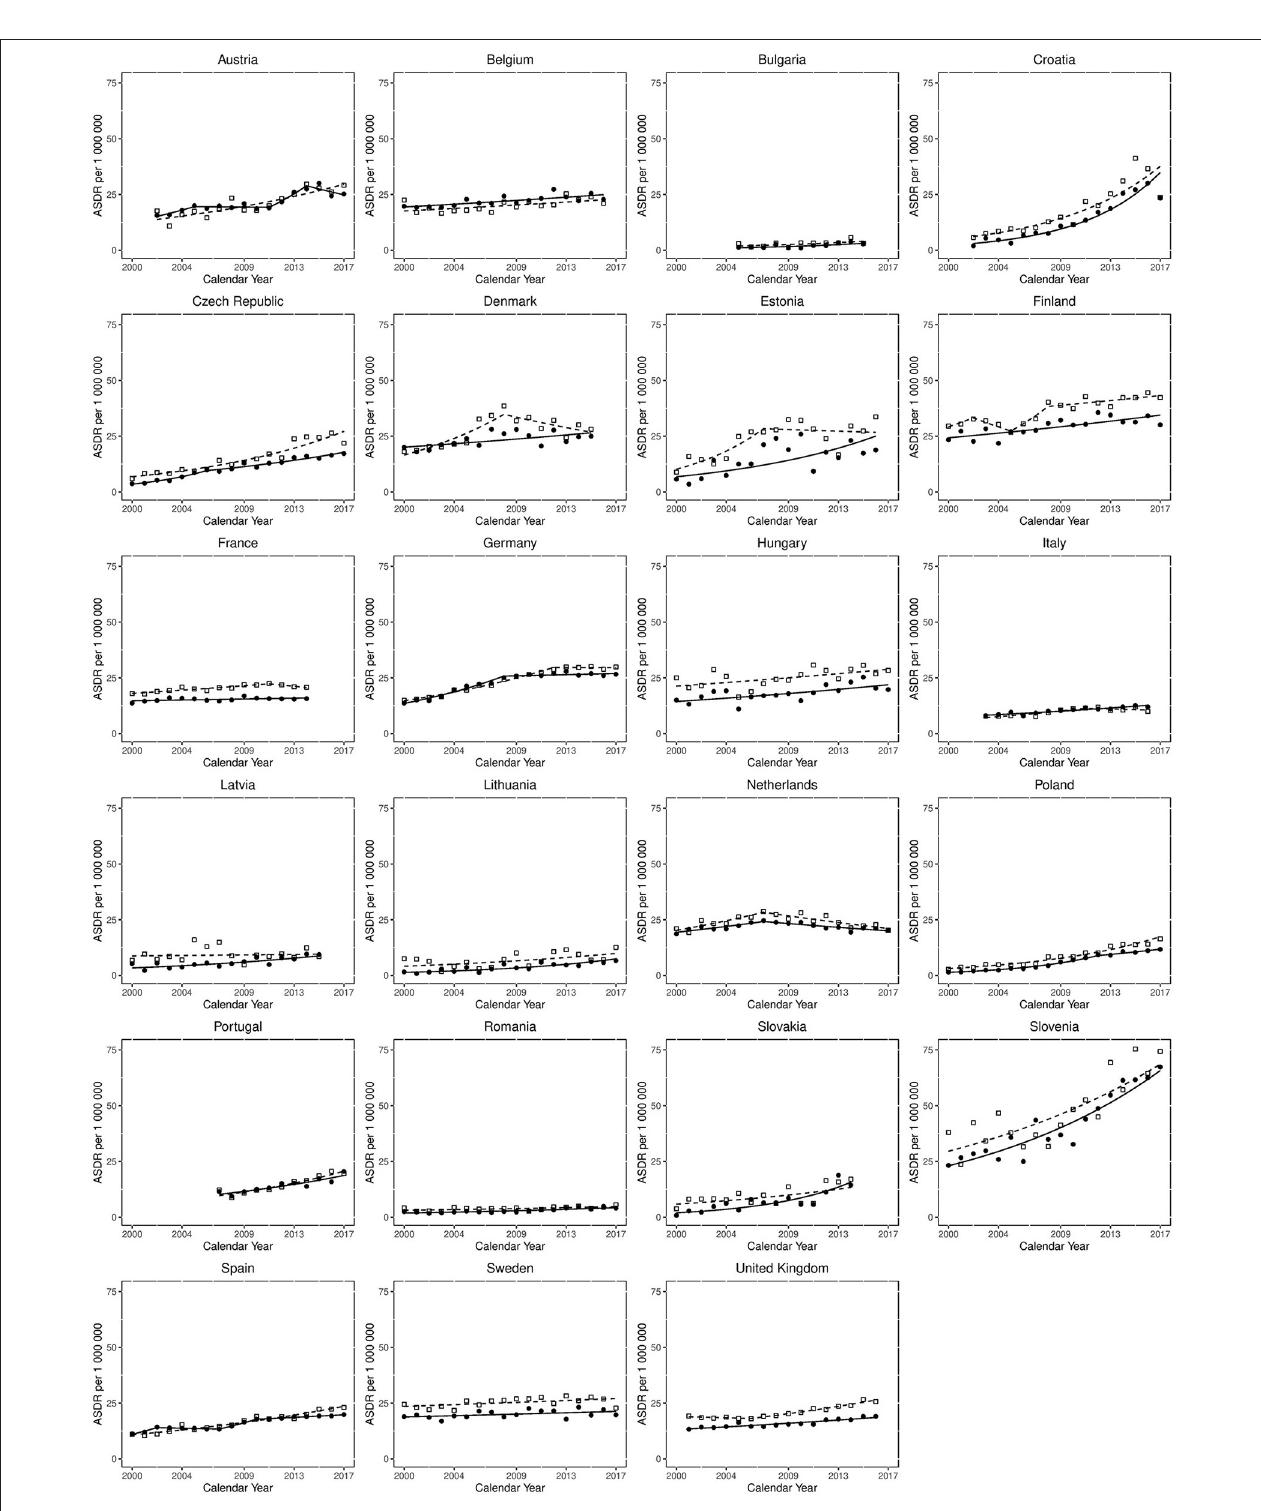
FIGURE 2 | Joinpoint regression analysis for trends in age-standardised death rates from non-rheumatic aortic stenosis for those aged > 45 years in Europe from 2000 to 2017. Clear squares indicate males; filled circles indicate females. The lines (dotted for males, solid for females) represent modelled trends based on joinpoint